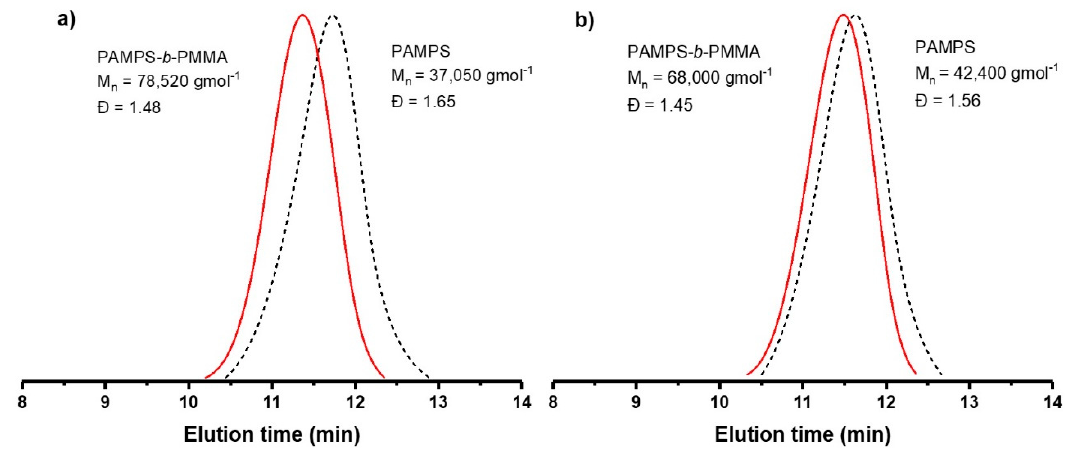
Figure 5. GPC elugram of PAMPS- b -PMMA copolymers with ( a ) 12% mol and ( b ) 25% mol of AMPS.